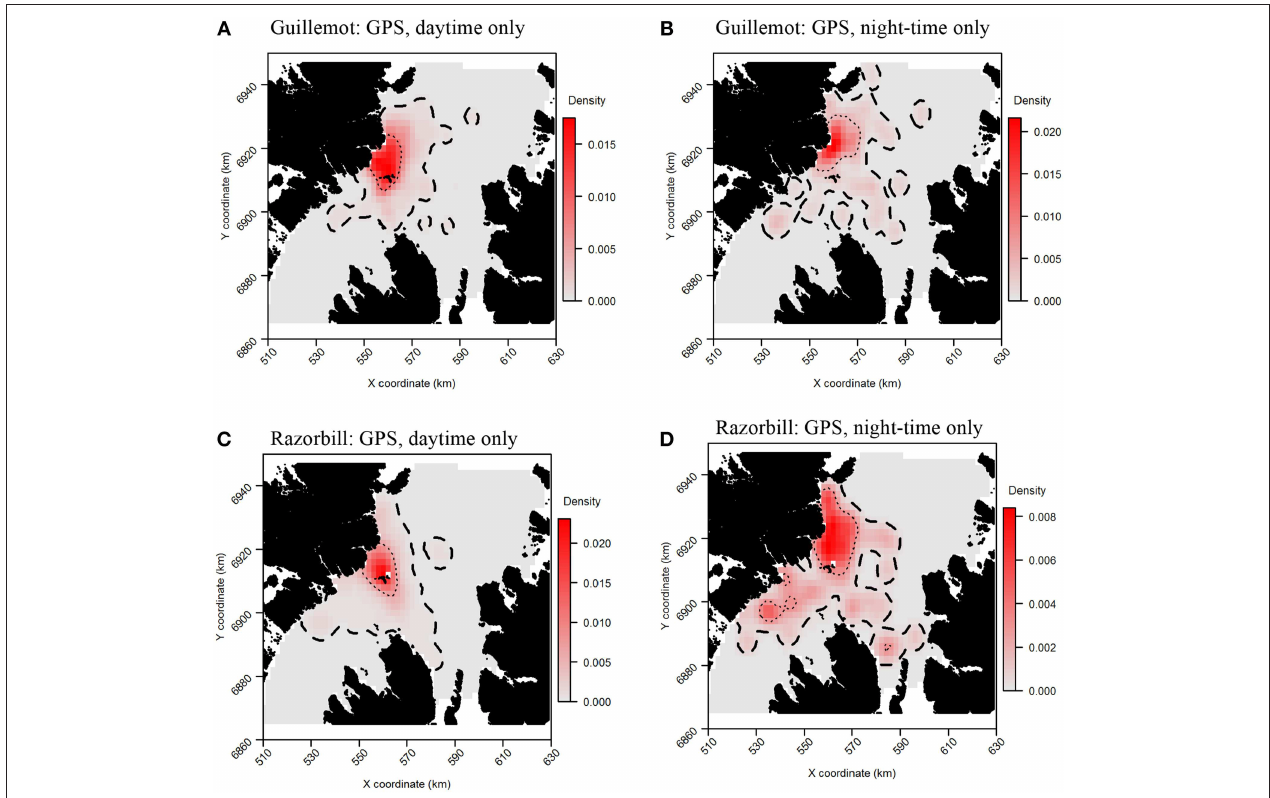
FIGURE 8 | Guillemot (A,B) and Razorbill (C,D) utilization distributions from daytime and night-time subsets of GPS data. Darker reds indicate higher probability densities. Thick, dashed line indicates extent of 95% home range; thin, dotted line indicates extent of 50% home range.